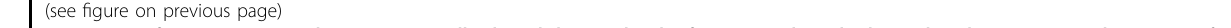
Fig. 2 Loss of PRLR expression breast cancer cells altered their molecular features and resulted in reduced sensitivity to therapy. a Left panel, MCF-7/WT, MCF-7/NT, and MCF-7/PRLRKO (SG1, SG2, and SG3) cell lines were lysed and western blotting was carried out using antibodies against ER, E-cad, CK18, CK5/6, and β -tubulin. Right panel, confocal immuno fl uorescence images of snail (green), vimentin (red), and nucleus (DAPI) (blue) of MCF-7/WT, MCF-7/NT, and MCF-7/PRLRKO (SG1, SG2, and SG3) cell lines. Scale bar, 10 μ m. b Proliferation SRB assays were performed on MCF-7/NT and MCF-7/PRLRKO (SG1) cell lines following 3 days treatment with tamoxifen (0 – 200 μ M). Results are expressed as mean ± SEM of four replicates of three independent experiments *** P 0.0002 (two-way ANOVA). c Left panel, SKBR-3/WT, SKBR-3/NT, and SKBR-3/PRLRKO (SG1, SG2, and SG3) cell lines were lysed and western blotting was carried out using antibodies against HER2, Phospho-HER2, E-cad, CK18, and β -tubulin. Right panel, confocal immuno fl uorescence images of PRLR (green), E-cad (red), and nucleus (DAPI) (blue) of SKBR-3/WT, SKBR-3/NT, and SKBR-3/PRLRKO (SG1, SG2, and SG3) cell lines. Scale bar, 10 μ m. d Proliferation SRB assays were performed on SKBR-3/NT and SKBR-3/PRLRKO (SG3) cell lines following 3 days treatment with lapatinib (0 – 25 μ M). Results are expressed as mean ± SEM of triplicates of four independent experiments * P 0.03 (two-way